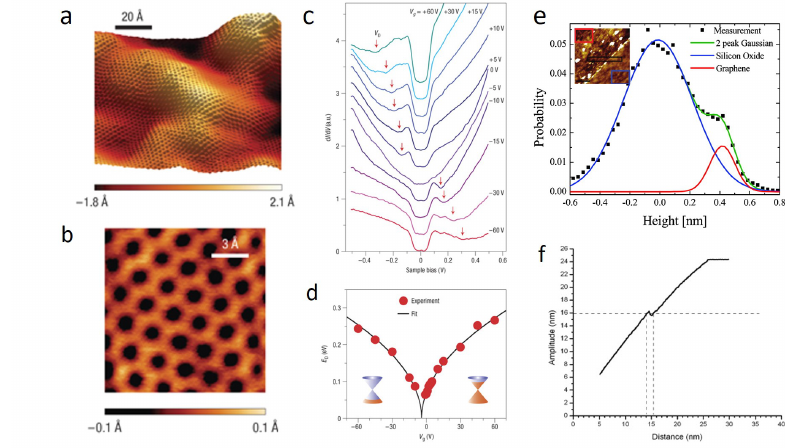
Figure 2. ( a – c ) Scanning Tunneling Microscopy (STM) of a graphene flake on a SiO 2 substrate. ( a )